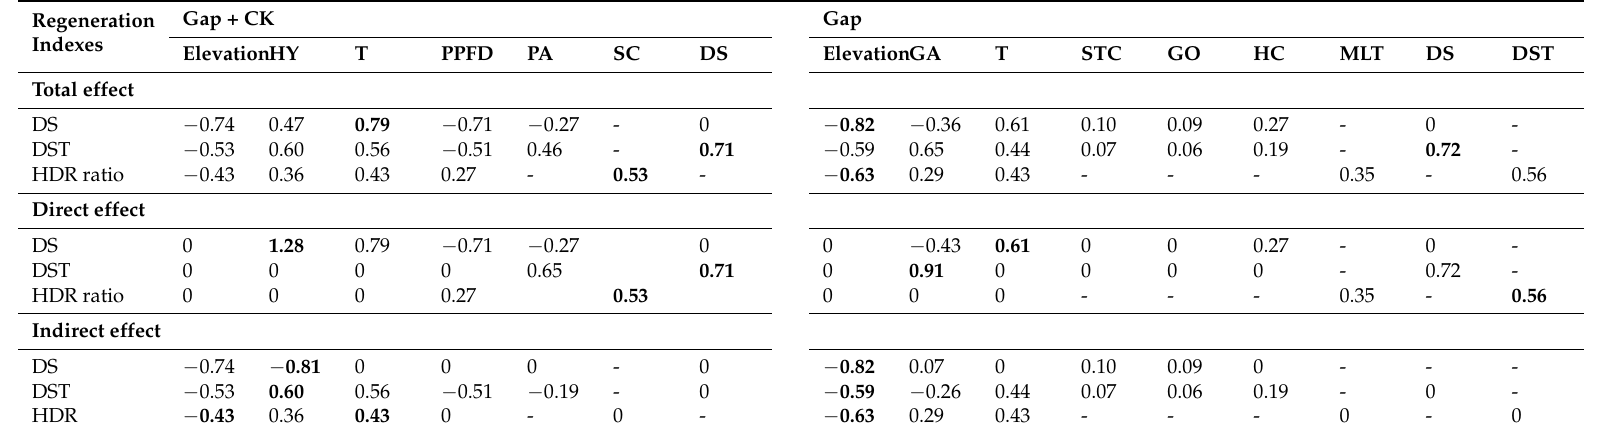
Table 4. Standardized total effect, indirect effect and direct effect of predictor variables on Abies faxoniana regeneration for the best SEMs shown in Figure 2. HY, T, PPFD, PA, SC, GA, STC, GO, HC, MLT, DS, DST, and HDR represent gap heterogeneity, temperature, photosynthetic photon flux density, plot area, shrub coverage, gap area, soil total C, gap openness, herb coverage, the moss layer thickness, density of Abies faxoniana saplings, density of Abies faxoniana small trees, and the HD ratio of the tallest Abies faxoniana small trees,